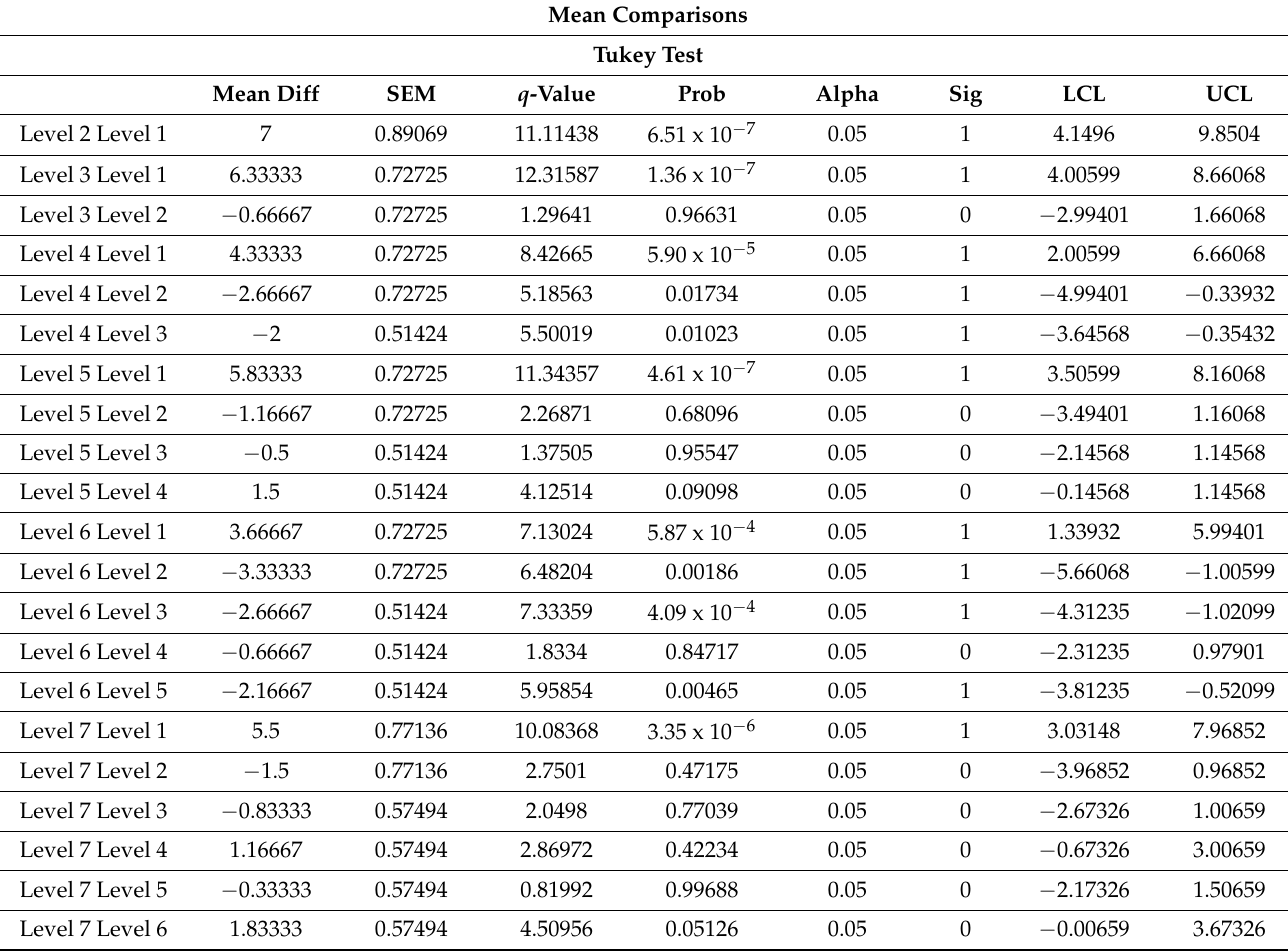
Table 2. Statistical comparison of pairs of experimental groups taking into account the values of bacterial colonies obtained after treatment, using the Tukey–Kramer